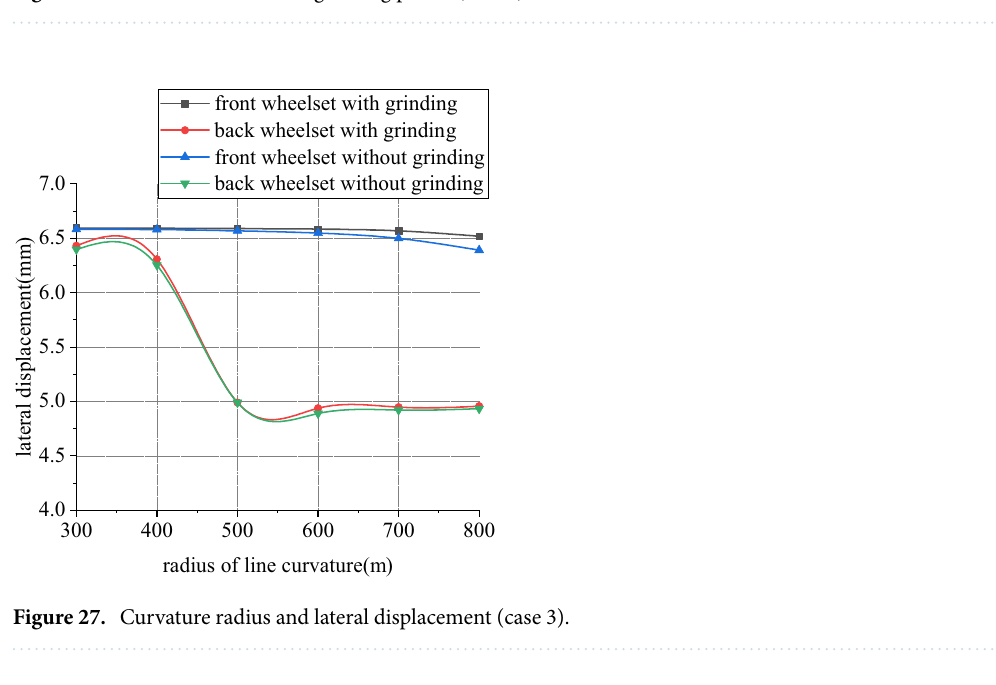
Figure 26. Curvature radius and grinding power (case 3).